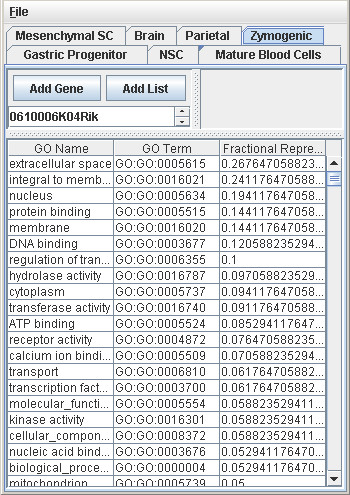
The GOurmet Vocabulary program calculates and displays the fractional representation of every GO term in each inputted expression profile. Depicted is a screen capture of the GUI showing the fractional representation of GO terms in a sample gene expression profile (in this case, the list of genes preferentially expressed in gastric zymogenic cells). Other profiles can be selected by clicking on the tabs. Results can be outputted in a multi-sheet MS Excel Workbook file (not depicted) for each expression profile, where one sheet summarizes the statistics of the annotation (number of genes in the profile, percent of those genes successfully annotated with GO terms, etc.), the second sheet lists every GO term associated with each gene, the third lists all the GO terms found in the profile, followed by the genes associated with each GO term. Results can also be output as tab-delimited Comparison files as input for GO Cartography.